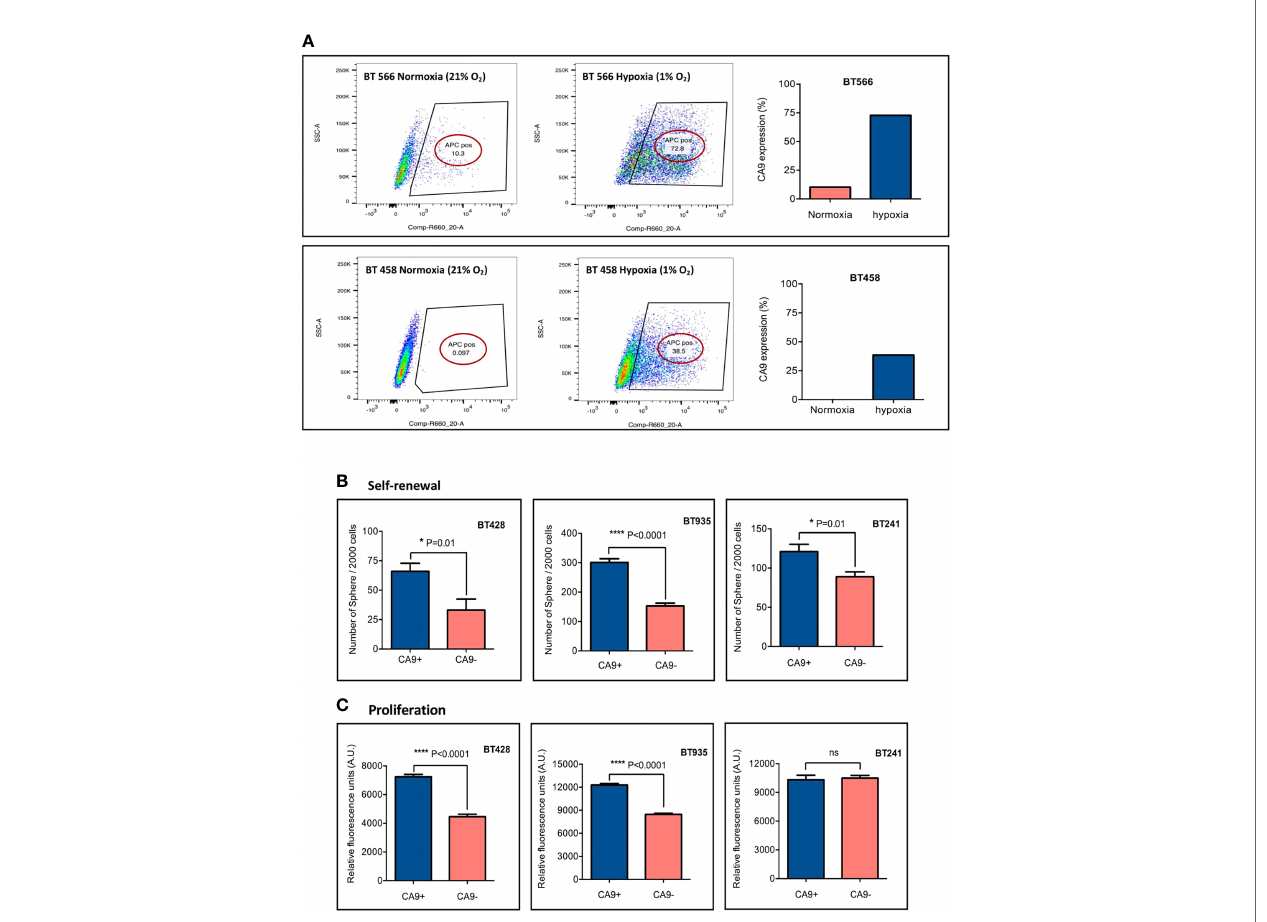
FIGURE 2 | CA9 expression elevates in hypoxic condition and is associated with higher level of self-renewal and proliferation. (A) CA9 surface expression was evaluated after cells were cultured in normoxia or hypoxia (1% O 2 ) for 5 days; and the results indicated a dramatic increase in CA9 expression on both GBM BTIC lines upon exposure to hypoxia. (B) Signi fi cant increase of self-renewal capacity as measured by secondary sphere formation assay and (C) proliferative potential as measured by PrestoBlue proliferation assay is seen in CA9+ when compared to CA9- cells. (P value: **** <~0.0001, * 0.01, ns: non-signi fi cant) (mean±SEM, two- tailed